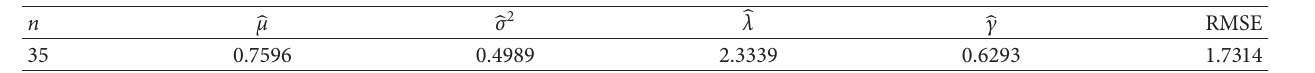
Table 6: The ML estimates and the RMSE value for ARW data with independent innovations.